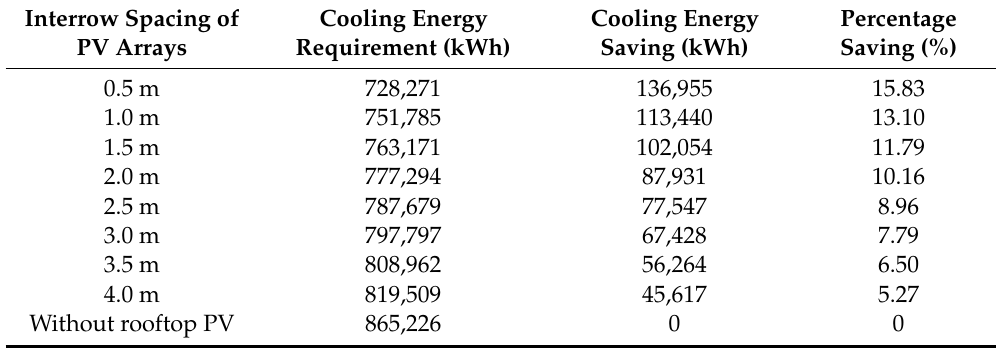
Figure 4. Roof surface temperatures without and with rooftop PVs at different interrow distances. ( a ) Inside. ( b ) Outside. Table 5. Cooling energy requirement and saving at various interrow distances of PV